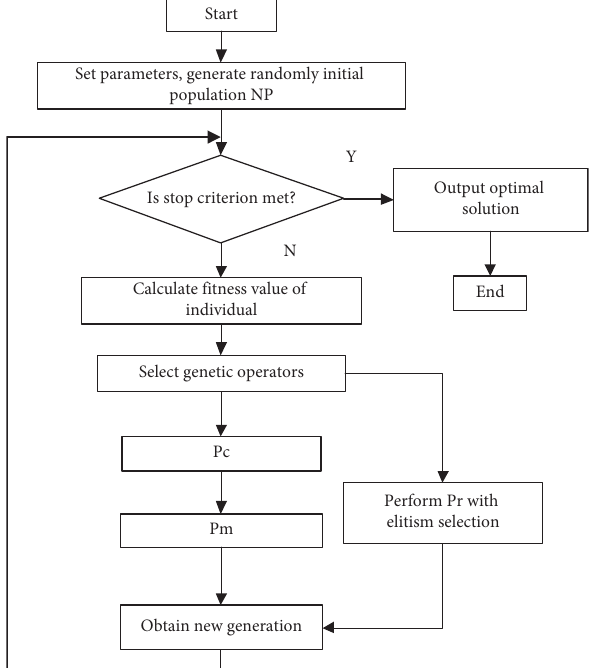
Figure 3: Optimization process of improved genetic